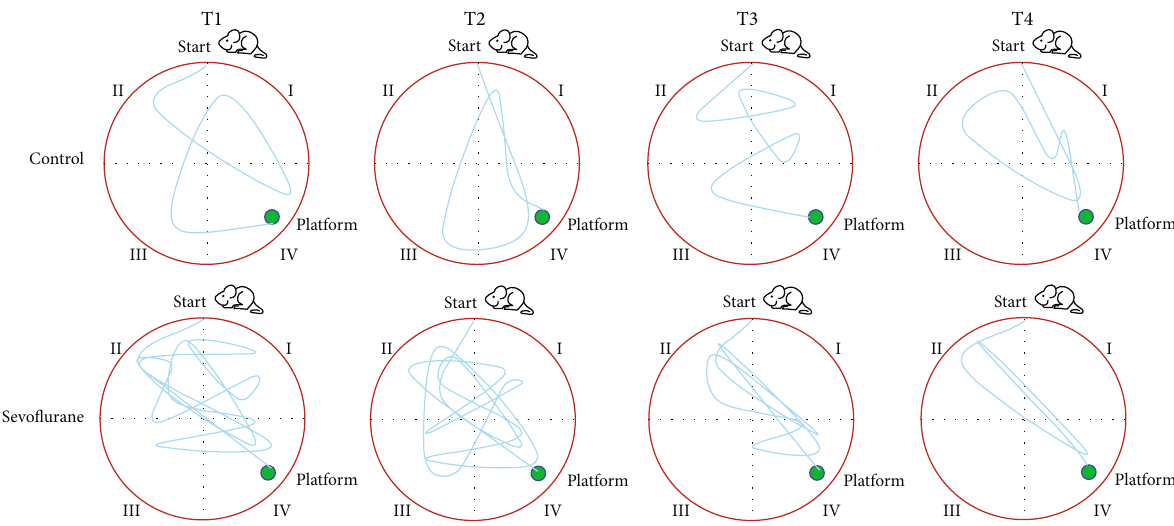
Figure 1: Morris water maze (MWM) test between the control and sevo fl urane groups. MWM was divided into I, II, III, and IV quadrants, and a platform was placed in the IV quadrant. According to the di ff erent time points of the behavioral experiment test, the mice were stopped for the inhalation of sevo fl urane or oxygen after 12 h (T1), 24h (T2), 48 h (T3), and 72h Table 1: Morris water maze between control and sevo fl urane subgroups ( n = 8 ).